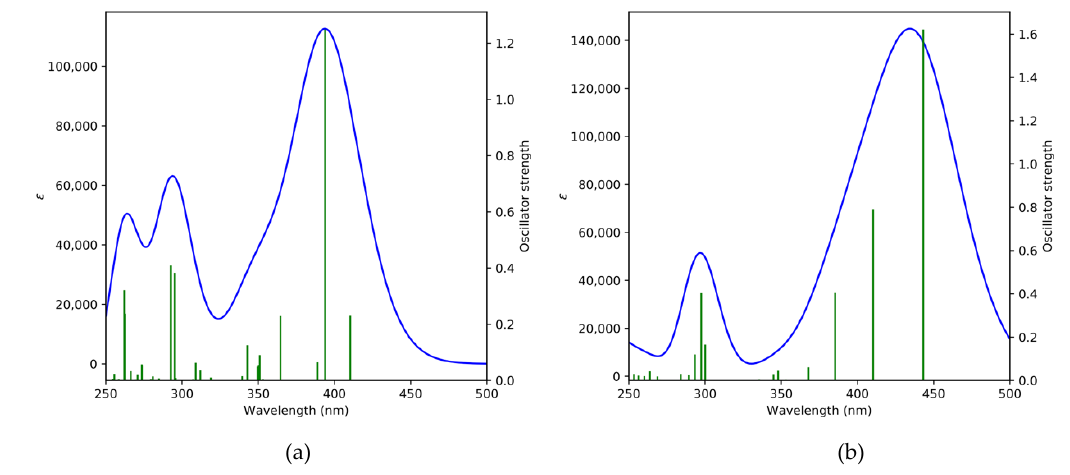
Figure 7. Simulated UV-Vis spectra of DAFCHO ( a ) and FDACHO ( b ) calculated at the TD-M062x/cc-pVTZ level of theory with PCM parameters for chloroform using FWHM (Full Width at Half Maximum) of 3000. Individual excitations are displayed as vertical lines with heights representing their oscillator strengths.